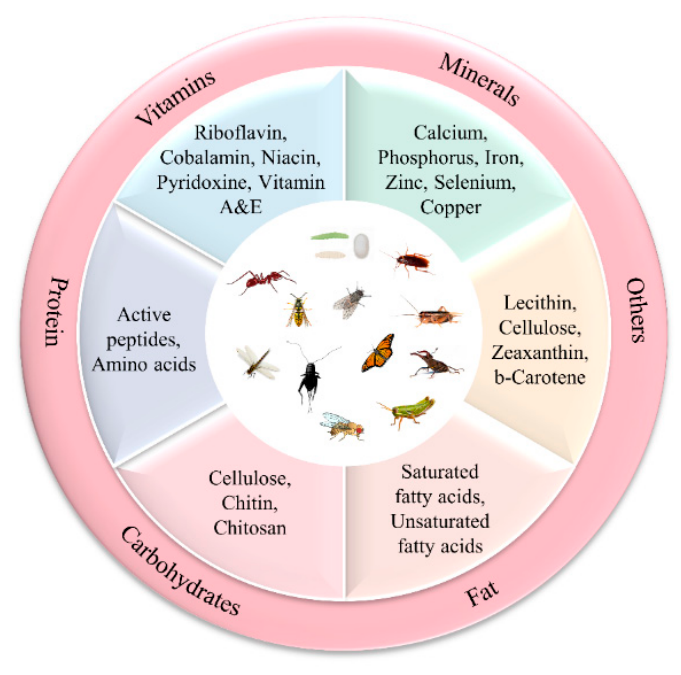
Figure 1. Nutrient composition of edible insects.